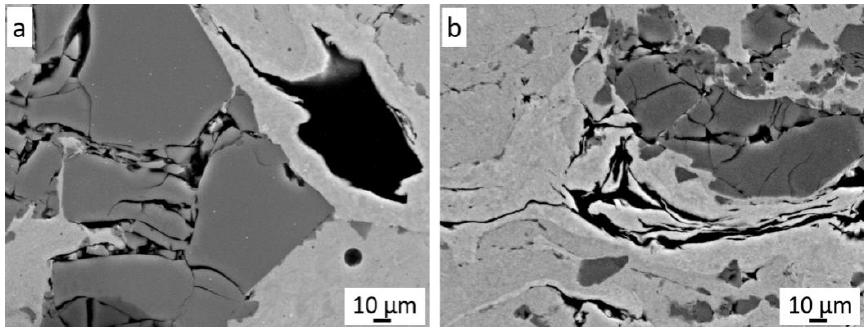
Figure 7. Slightly ( a ) and severely ( b ) deformed Ni-25Gr powder grains (black).